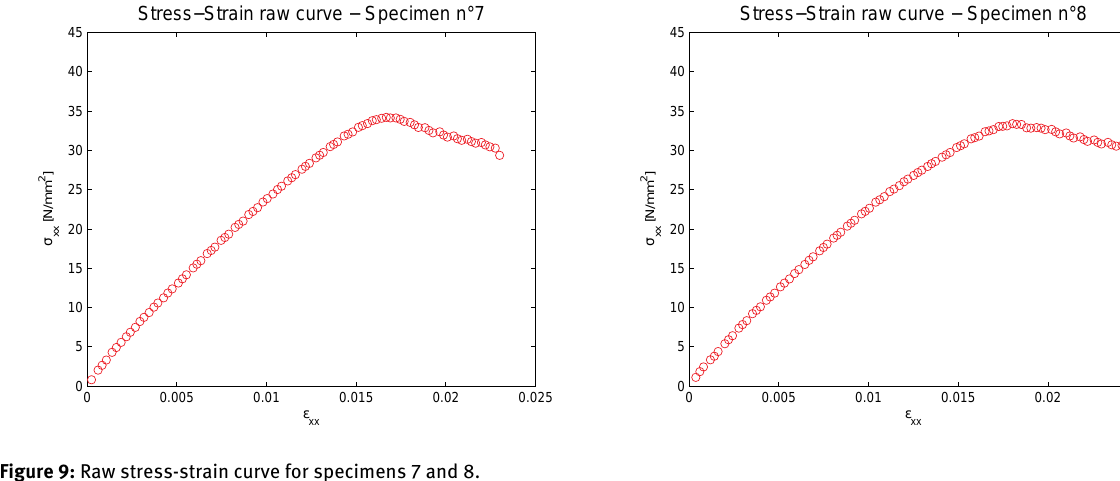
Figure 9: Raw stress-strain curve for specimens 7 and 8.